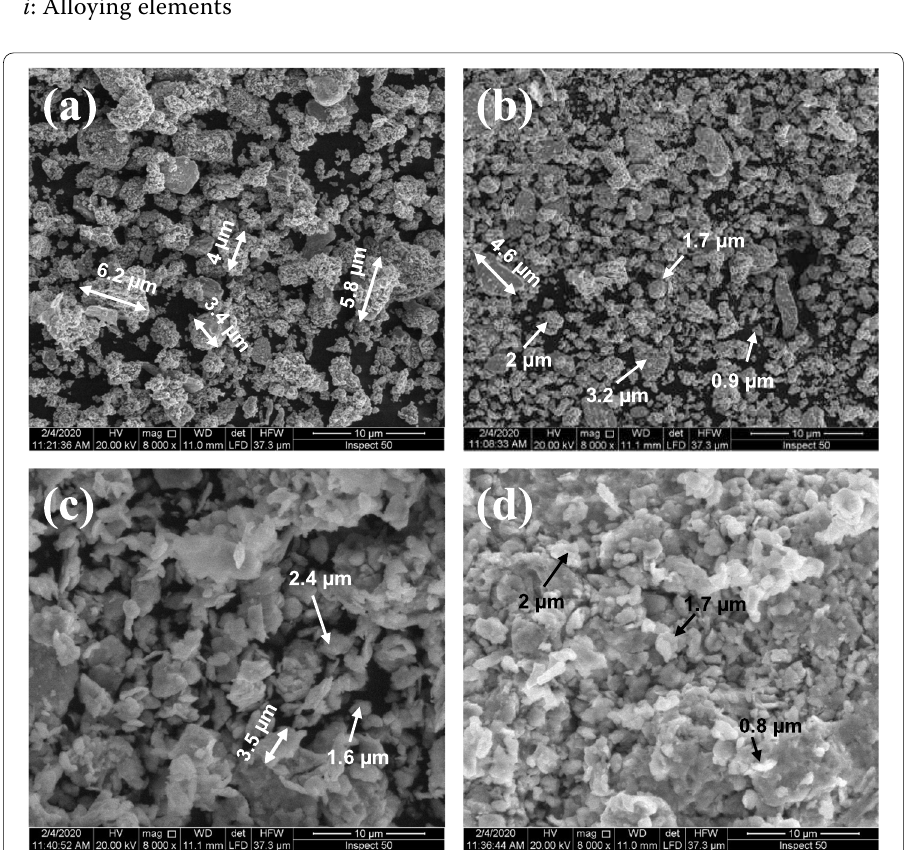
Fig. 1 SEM micrographs of the (CrFeCoNi) 1-x (WC) x mixed powder with a value of x equal ( a )0, ( b )5, ( c )15, and ( d )20 wt%